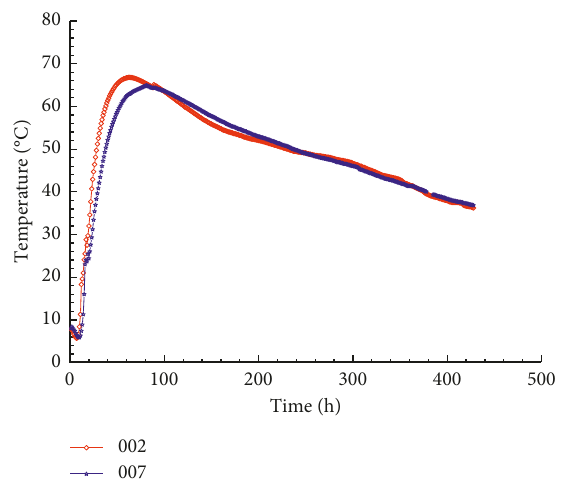
Figure 8: Temperature comparison between Points 002 and 007.